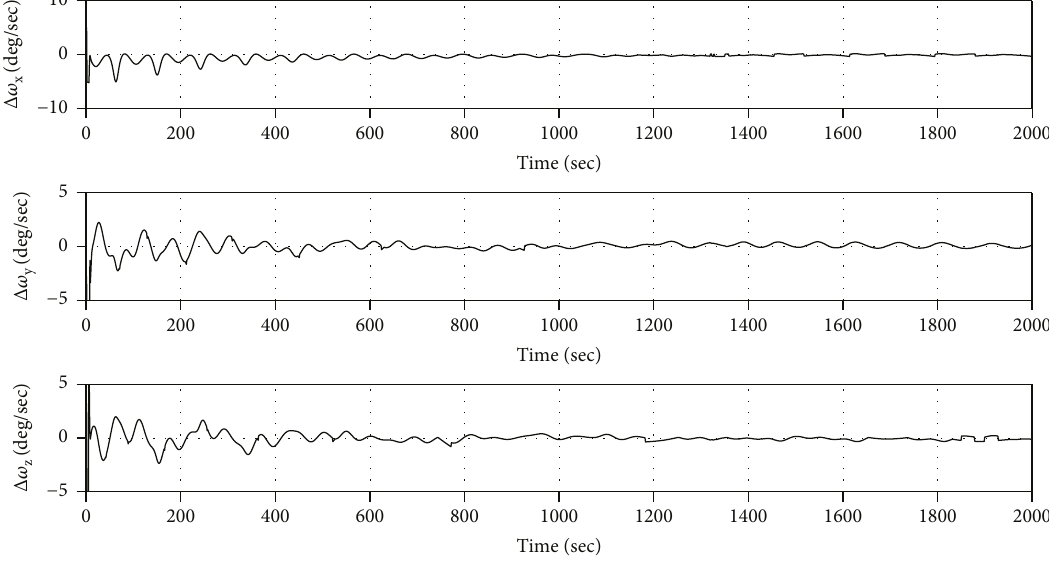
Figure 6: Di ff erence between actual and measured angular rates ( ω